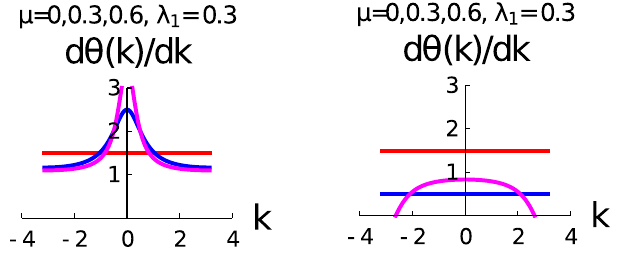
( ) with k . Different curves are for different values of μ , red ( μ = 0), blue ( μ = Figure 6. Shows the variation of θ ( ) d k dk 0.3), magenta ( μ = 0.6) respectively. The left panel is for the λ 2 = μ + λ 1 and the right panel is for λ 2 = μ − λ 1